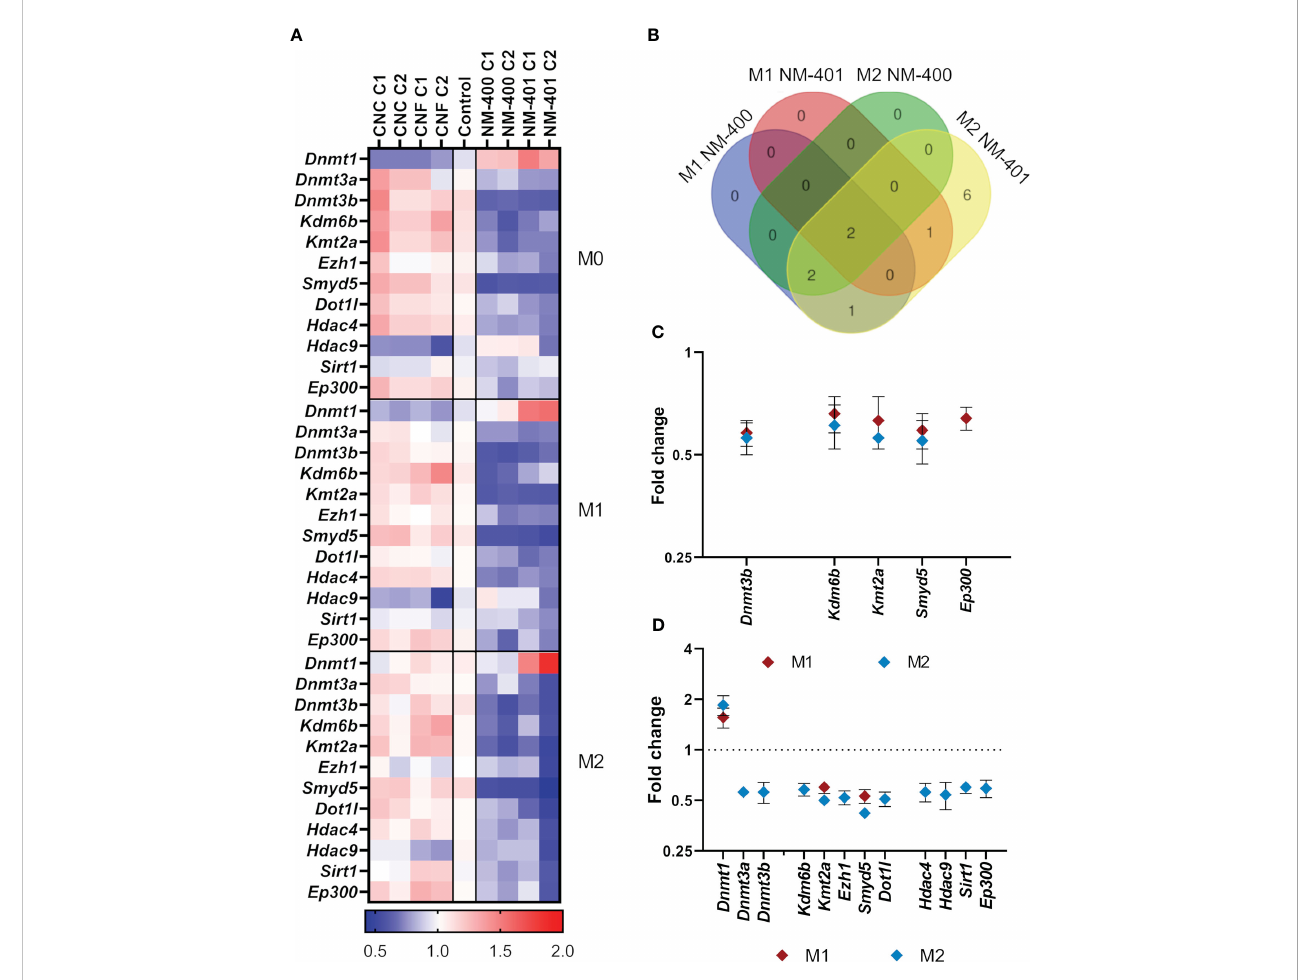
FIGURE 5 Effects on the expression of genes regulating epigenetic modi fi cations. Changes in gene expression were assessed by qPCR following exposure to CNC, CNF, NM-400 and NM-401. C1: 0.15 m g/cm 2 and C2: 2.7 m g/cm 2 . (A) Heatmap of the mean fold changes in regulated genes following 24h of nanomaterial exposure in M0, M1 and M2 macrophages. (B) Venn diagram illustrates commonly regulated genes in M1 and M2 cells after NM-400 and NM-401 exposure. (C) Genes signi fi cantly regulated following exposure to NM-400. (D) Genes signi fi cantly regulated following exposure to NM-401. Data represent mean ± SD, (n=5),